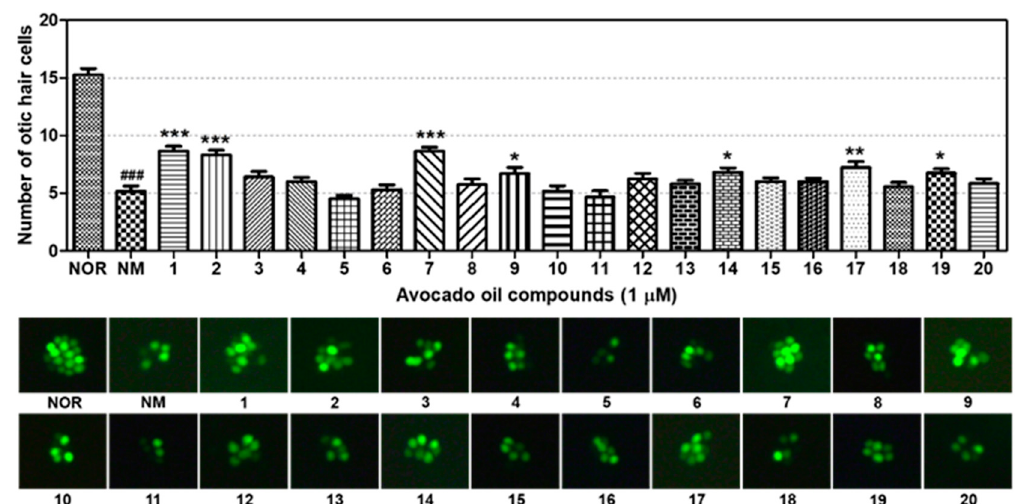
Figure 3. Otic hair cell recovery of compounds 1 – 20 after neomycin-induced hair cell damage. Data are presented as means ± SEM. ### p < 0.001 (NOR group versus NM group). * p < 0.05, ** p < 0.01 and *** p < 0.001 (NM versus avocado oil compounds treated groups).